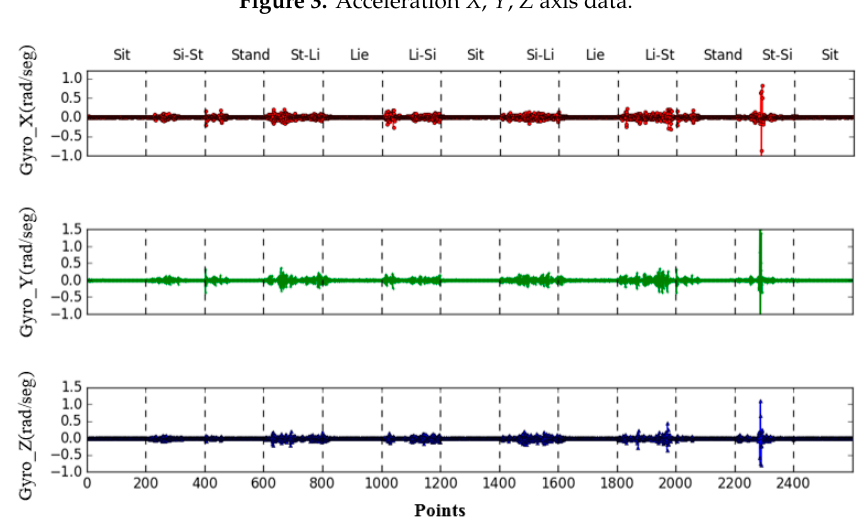
Figure 3. Acceleration X , Y , Z axis data.